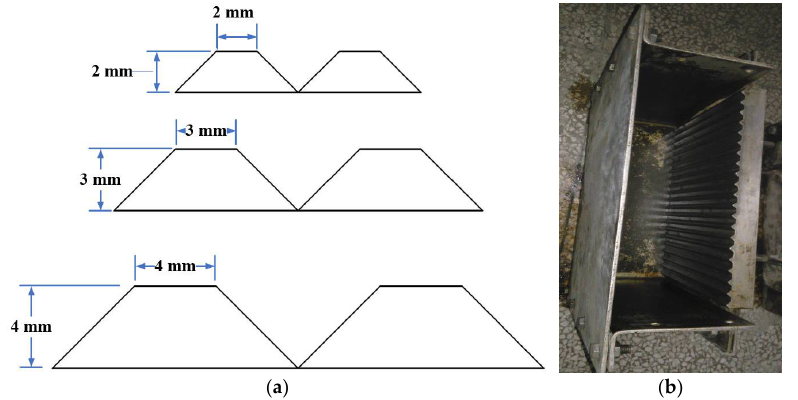
Figure 9. Morphology of dentate joints and preparation of molds: ( a ) dentate joints morphology; ( b ) preparation of mold.